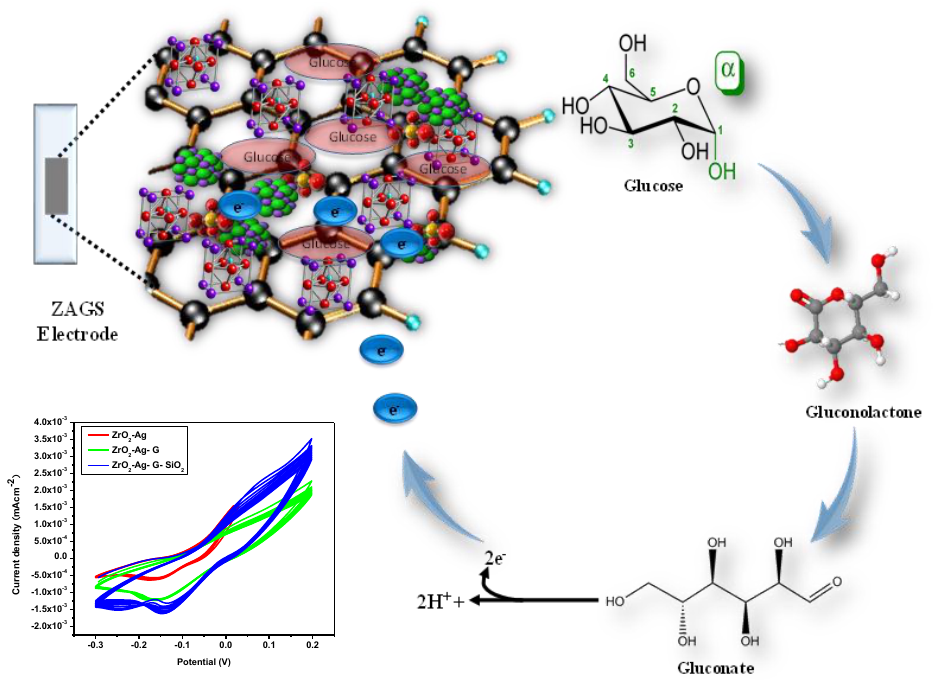
Scheme 1. The glucose-sensing mechanism of the ZAGS